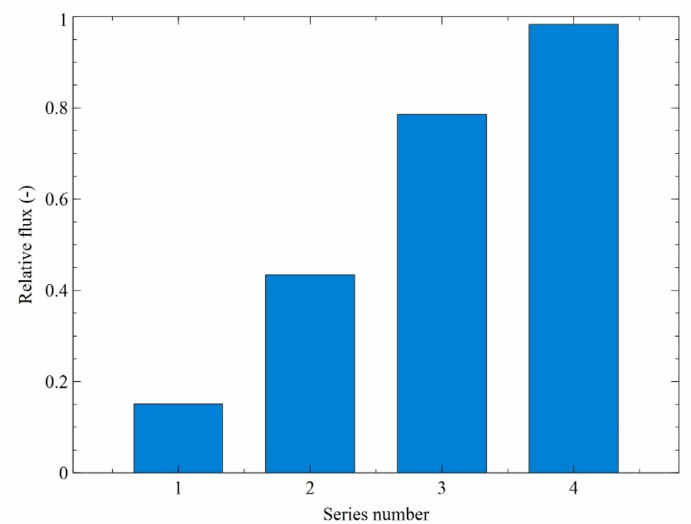
Figure 7. Changes in the relative flux of UF membrane. Relative flux: 1—steady-state, after 180 min of the broth filtration process, 2—after membrane rinsing with water, 3—after membrane cleaning with 1% NaOH solution (5 min), 4—after membrane cleaning with 1% NaOH solution (10